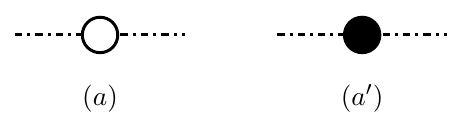
Figure 5 . Diagrams contributing to the corrections of ˆ G